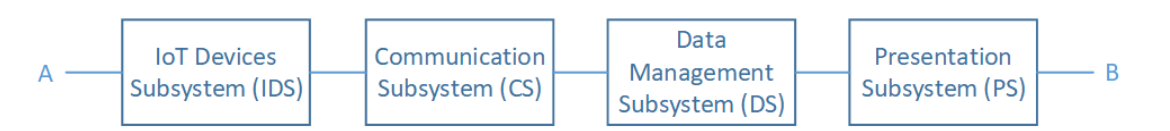
Figure 14. Framework of IoT End-to-End system RBD